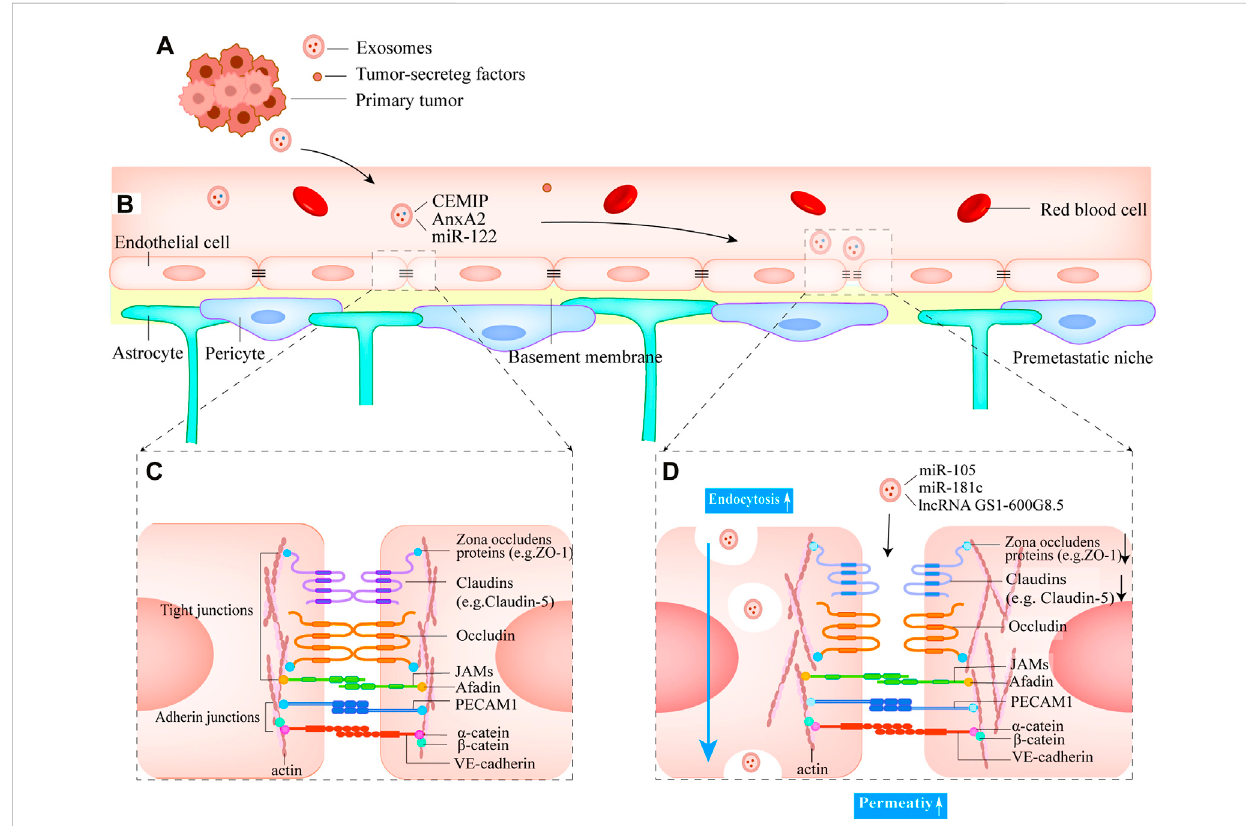
FIGURE 3 Small EVs mediatetheformation ofpre-metastatic niches andthedestruction oftheBBB (A) Breasttumorcells release smallEVs into thebloodand eventually form the pre-metastatic niches in the brain (B) Normal structure of BBB (C) The structure of the junctional complexes between endothelial cells. The complex typemainly consists oftight junctions and adherens junctions, which can effectively ensurethe low permeability of BBB (D) Small EVs derived from breast primary tumor cells disrupt tight junctions. Mainly decreases the expression of proteins ZO-1 and Claudin 5 and increases BBB permeability. Small EVs cross the BBB by